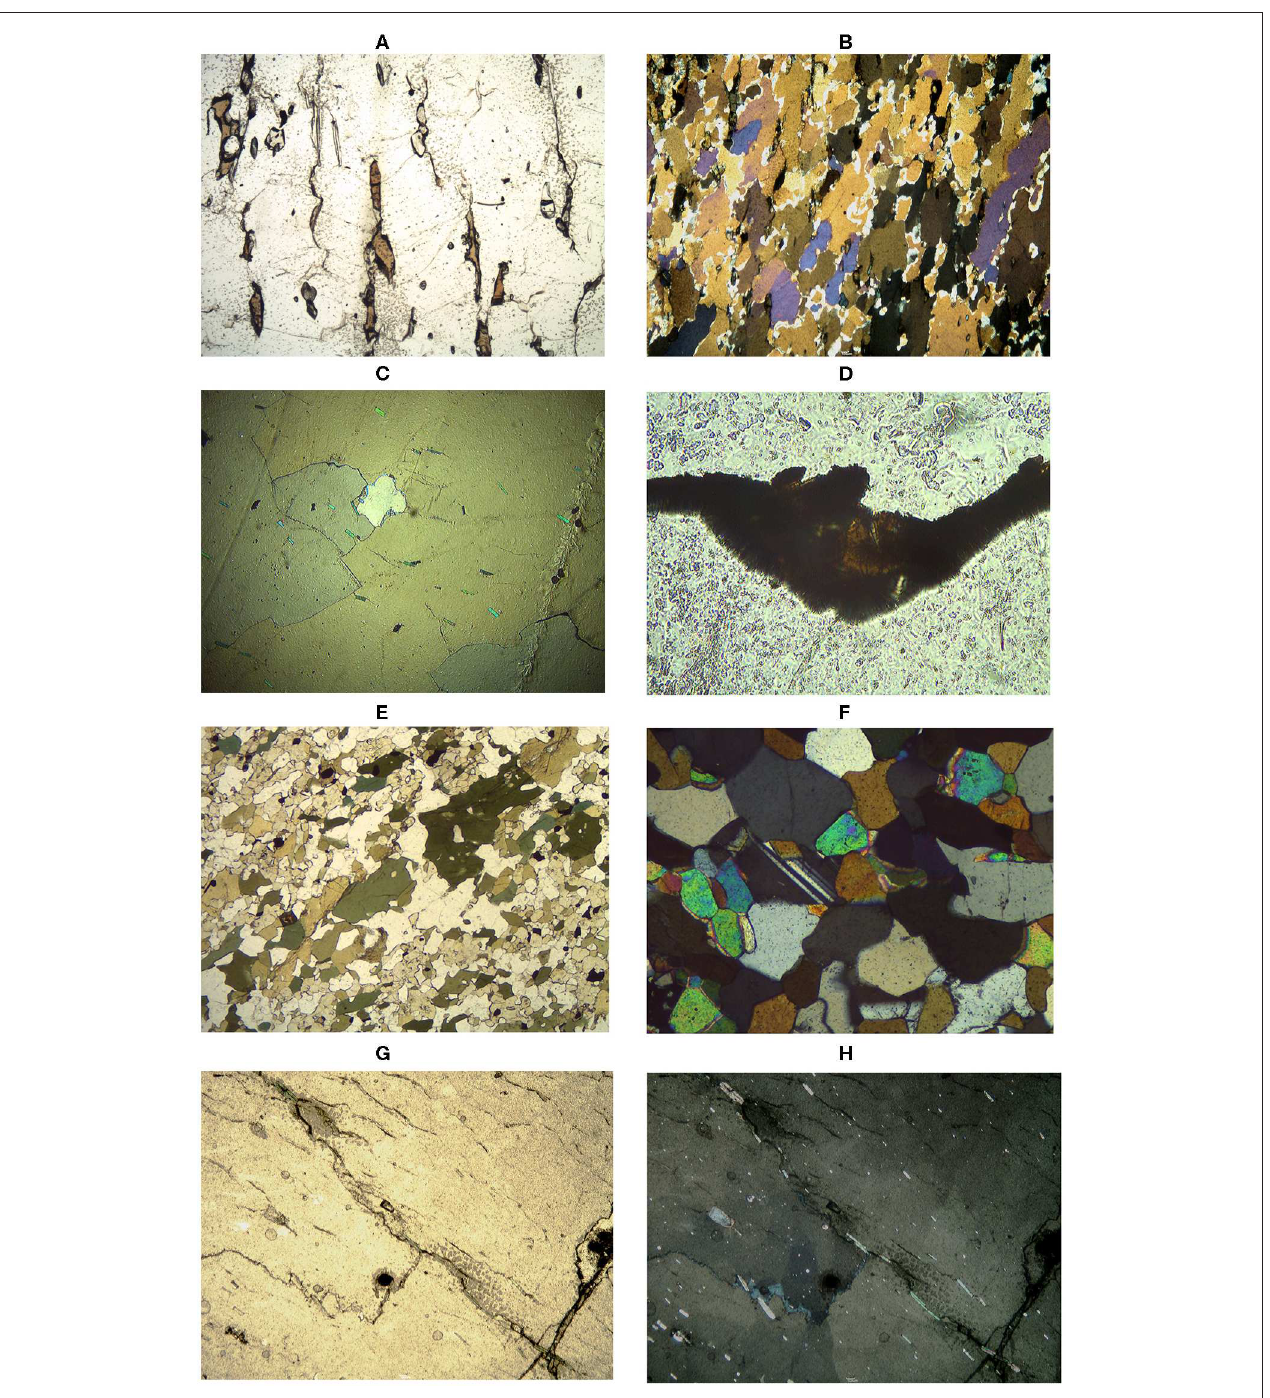
FIGURE 5 | Kelogi 9: (A) Quartz, staurolite, muscovite, and kyanite (PPL 4 × horizontal field width 0.55mm); (B) similar to (A) note the fine-grained texture (XP 2 × horizontal field width 1.1mm); Naibor Soit Kubwa 33: (C) sub-parallel muscovite crystals included in and interstitial to quartz (XP 2 × horizontal field width 1.1mm); (D) magnetite crystal with dark metallic luster and a dendritic habit (PPL 40 × horizontal field width 0.055mm); Naibor Soit Kubwa 28: (E) foliation defined by hornblende (PPL 2 × horizontal field width 1.1mm); (F) plagioclase crystal with characteristic polysynthetic twinning surrounded by quartz and epidote (XP 10 × horizontal field width 0.22mm); Naibor Soit Ndogo 13 (thin section damaged during preparation): (G) pale green fuchsite crystals and colorless muscovite included in and interstitial to quartz (PPL 2 × horizontal field width 1.1mm); (H) same as (G) note the platy habit of fuchsite and muscovite (XP).